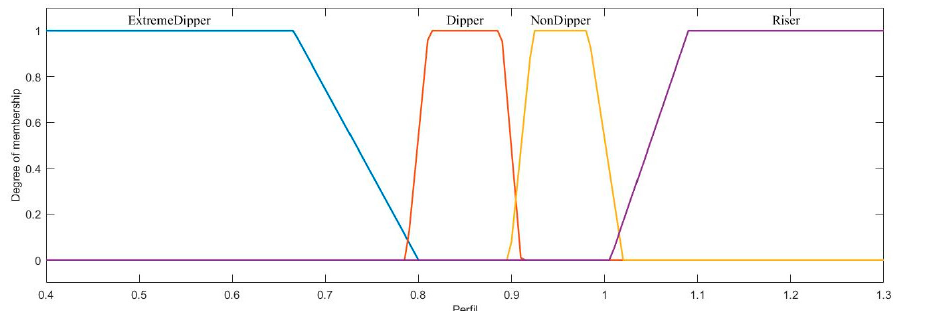
Figure 14. Nocturnal blood pressure level output.